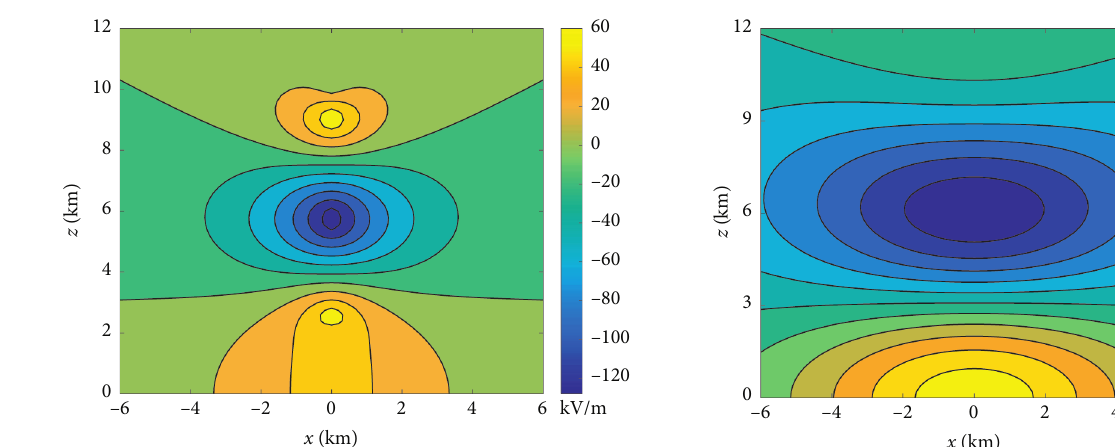
Figure 16: Contour of potential distribution on the longitudinal section while y �